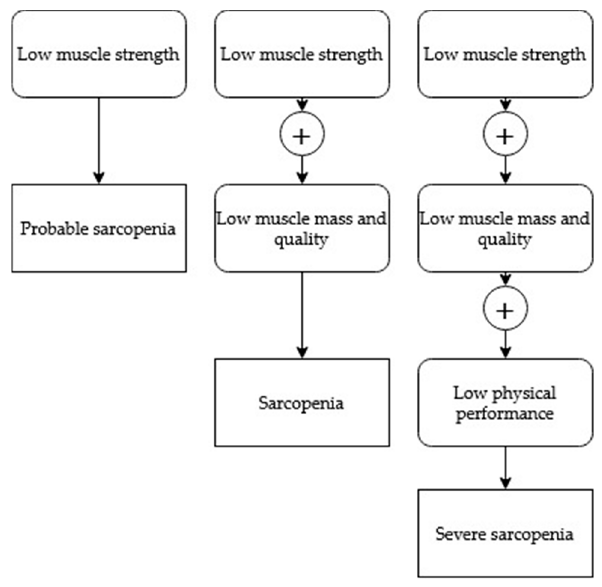
Figure 1. EWGSOP clinical practice algorithm for the diagnosis of sarcopenia.